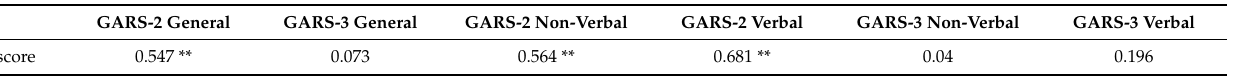
Table 1. Correlations of the verbal and nonverbal individuals’ screening score and their final diagnosis in each version of the GARS scale.